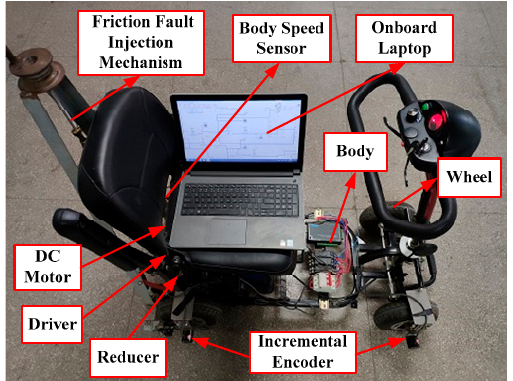
Figure 1. Electric scooter system.